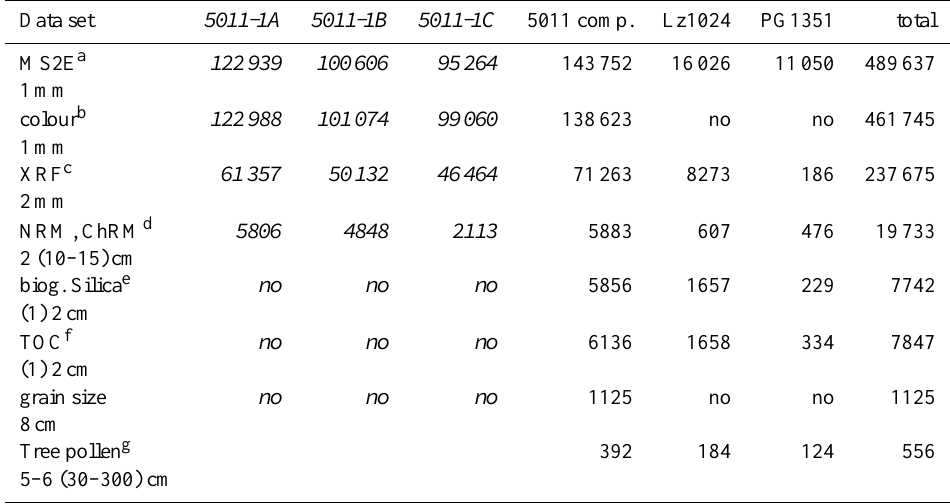
Table 2. Overview of stratigraphic data used for multi-proxy tuning of Lake El’gygytgyn sediments: number of obtained logger readings or individual determinations, with numbers in italics indicating raw data that was acquired on the full stratigraphic lengths of the respective cores. Scanning/sampling intervals are given below the parameter